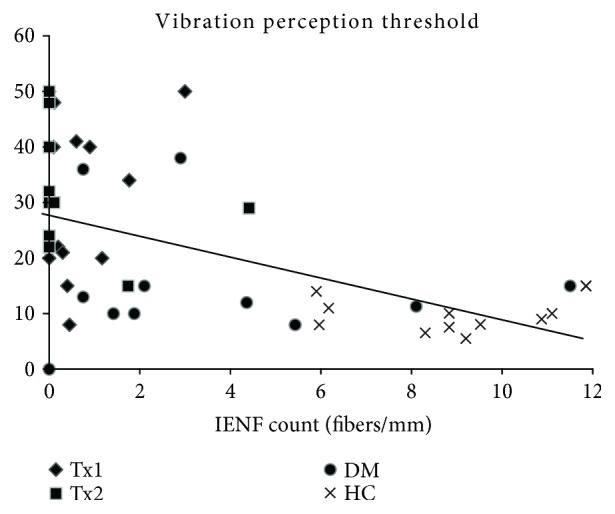
Correlation of intraepidermal nerve fiber density (IENFD) and vibration perception threshold.